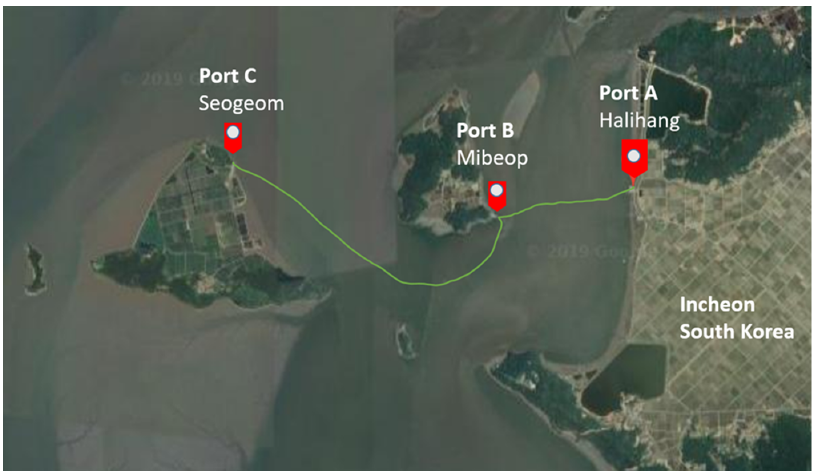
Figure 2. Voyage route for the case ship.